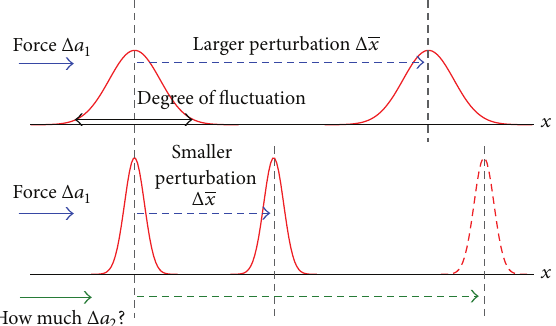
Figure 1: Dynamics of attractor